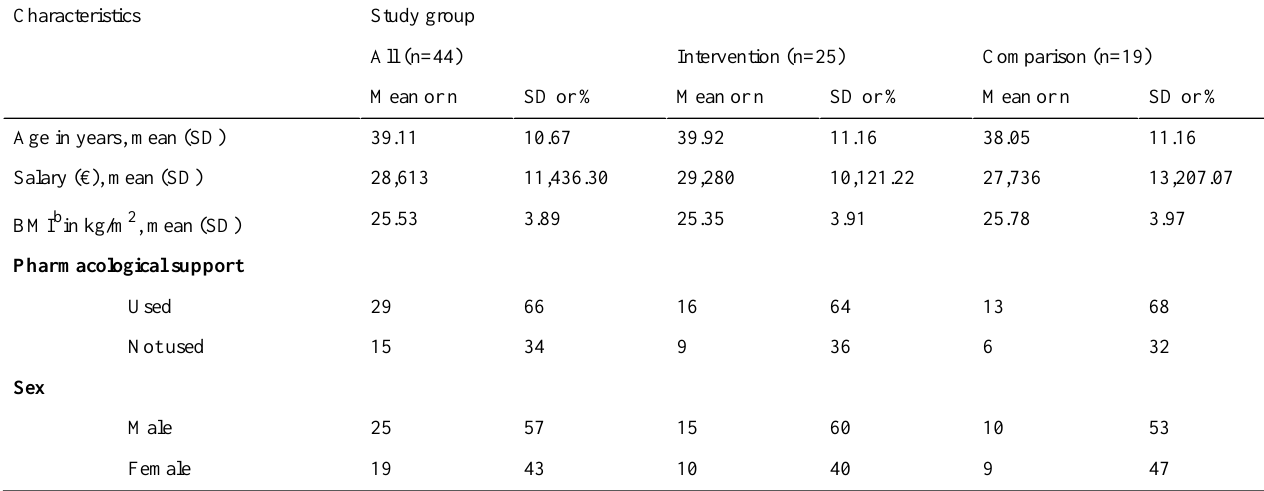
Table 1. Participant characteristics a .